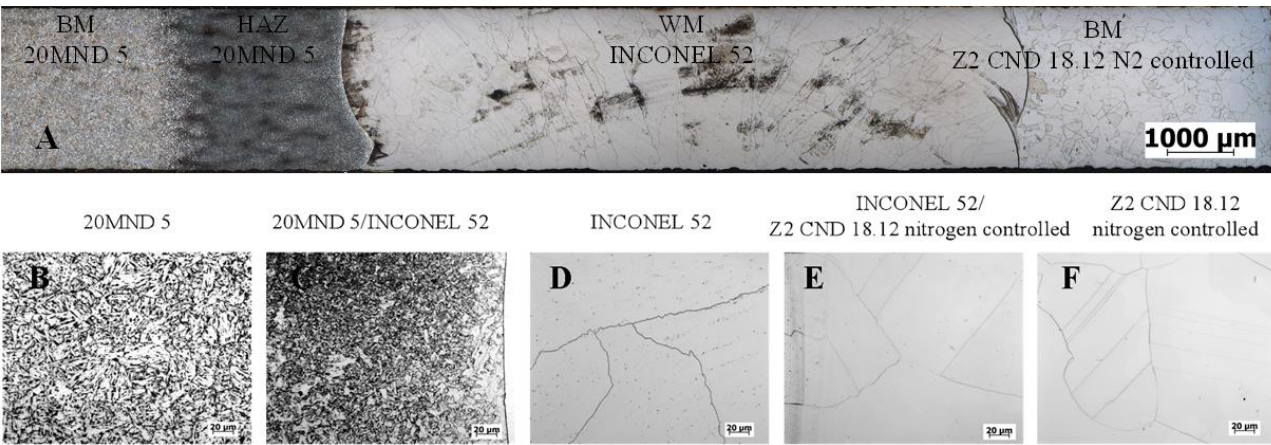
Figure 9. Optical microscope observation of the DMW joint. ( A ) at 25 magnification, the metallographic structure of welding joint; ( B ) at 500 magnification, the metallographic structure of the SG nozzle base metal; ( C ) at 500 magnification, the heat affected zone on the side of SG nozzle and the weld fusion line; ( D ) at 500 magnification, the metallographic structure of the weld; ( E ) at 500 magnification, the heat affected zone on the side of safe-end and the weld fusion line; ( F ) at 500 magnification, the metallographic structure of the safe-end base metal.